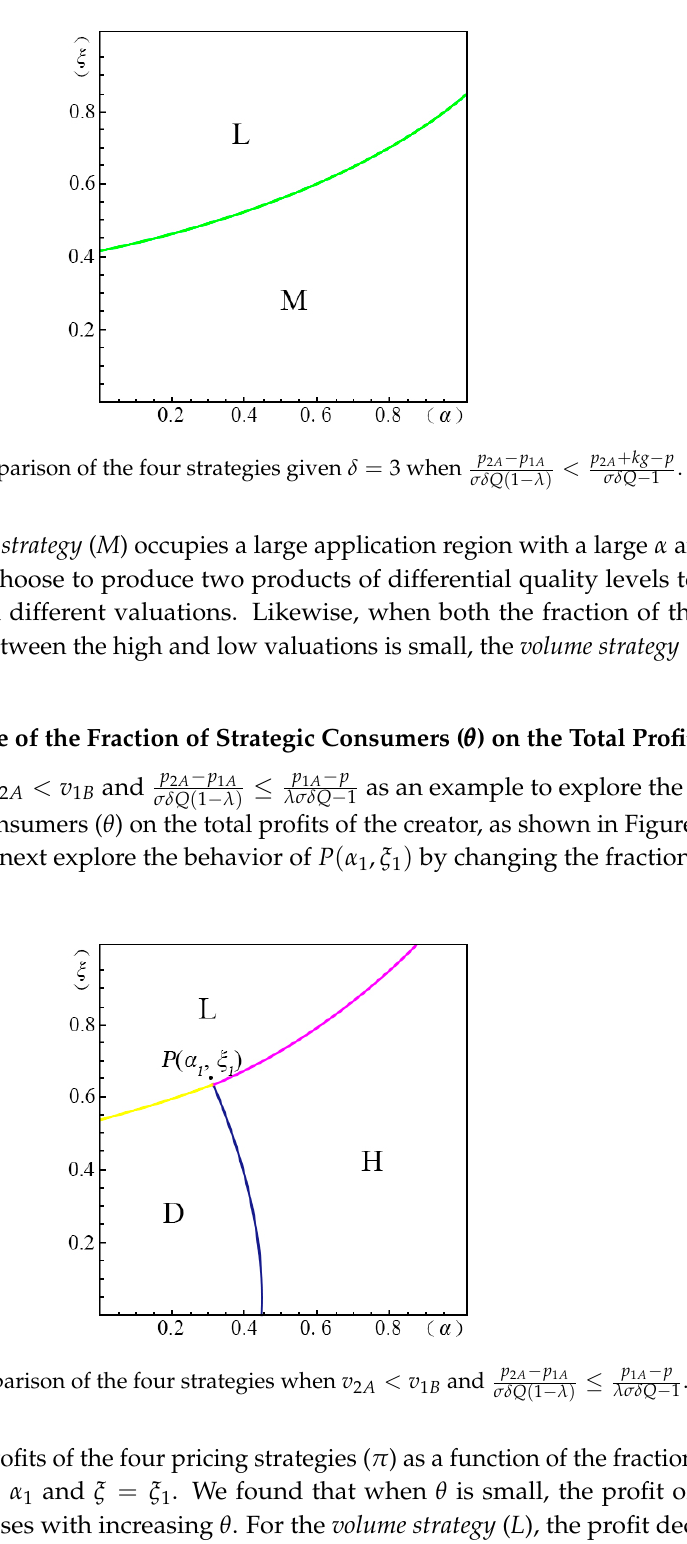
(cid:3408) (cid:3043) (cid:3118)(cid:3250) (cid:3397)(cid:1863)(cid:1859) (cid:2879)(cid:3043) . (cid:3097)(cid:3083)(cid:3018)(cid:4666)(cid:2869)(cid:2879)(cid:3090)(cid:4667) (cid:3097)(cid:3083)(cid:3018)(cid:2879)(cid:2869)